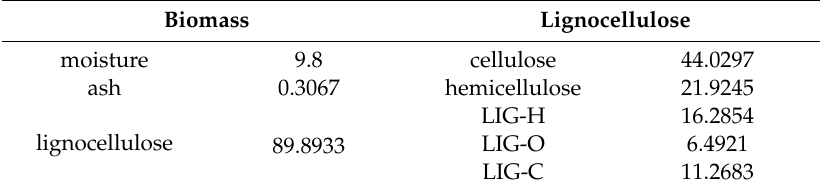
Table 4. Component mass fraction of the mixed pine and spruce